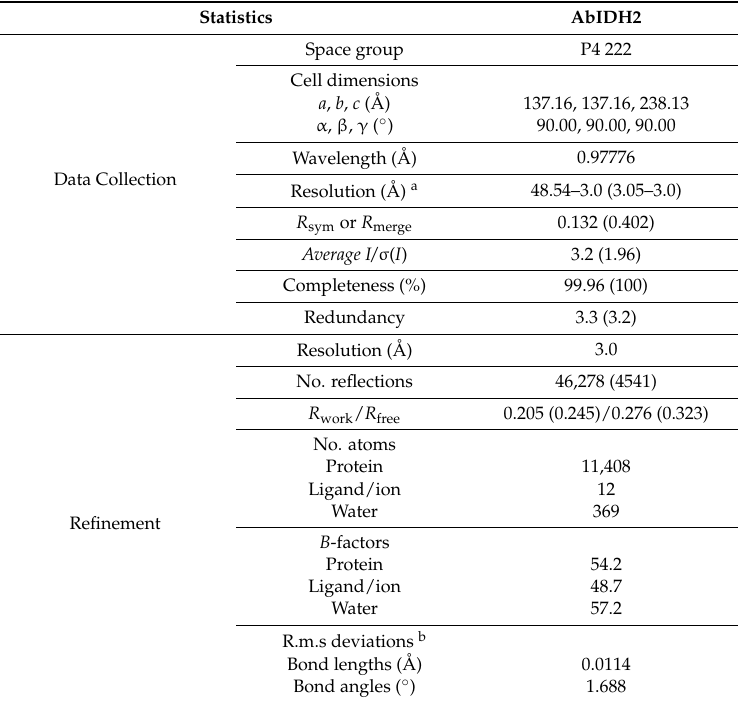
Table 2. Data collection and refinement statistics for